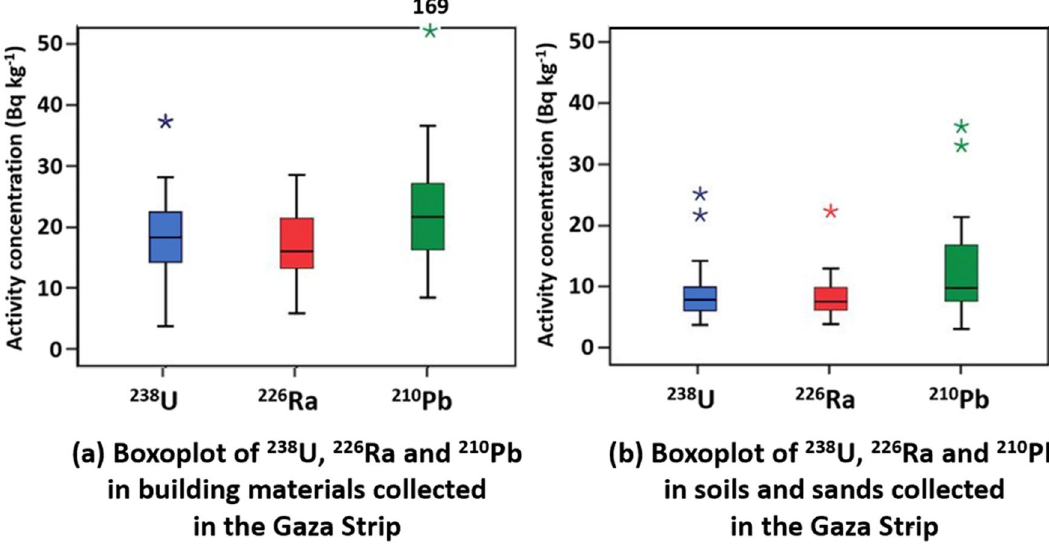
Figure 3 . Boxplots of the 238 U, 226 Ra and 210 Pb concentration in the ( a ) building materials and ( b ) soils and sands collected in the Gaza